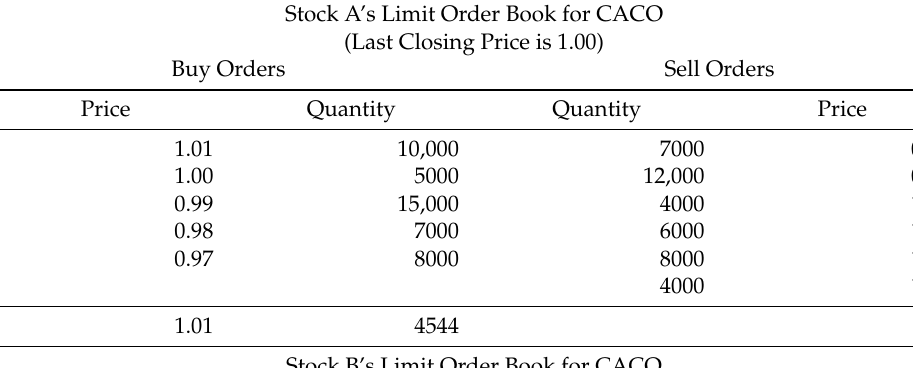
Table 3. Order Books at the Completion of CACO. Stock A’s Limit Order Book for CACO (Last Closing Price is